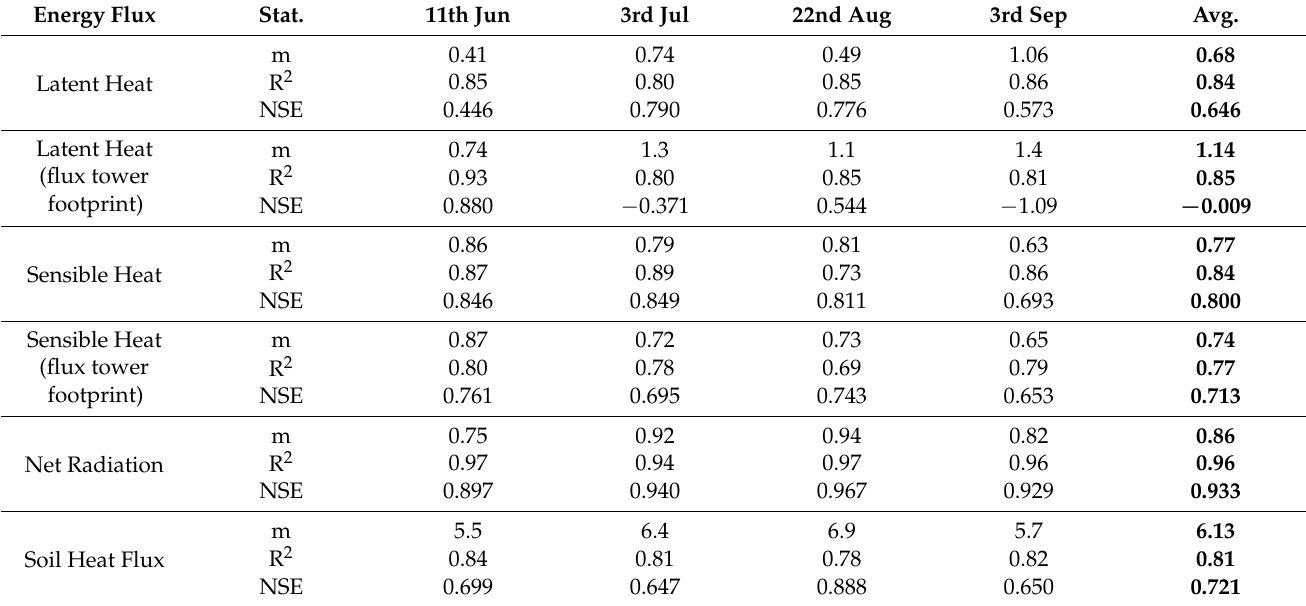
Table 4. Validation statistics by energy flux: linear interpolation slope (m), determination coefficient (R 2 ) and Nash–Sutcliffe Efficiency (NSE) for the four validation dates together with their average (Avg.). Energy Flux Stat.